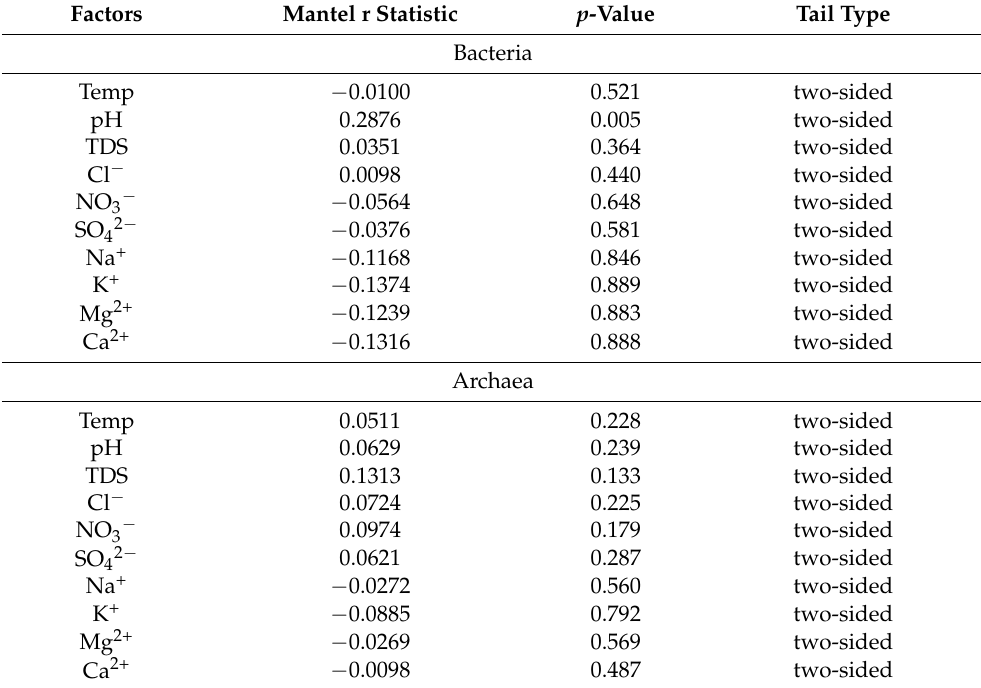
Table 2. Mantel tests using Spearman’s correlation (permutations = 999) of weighted UniFrac dissimilarities between all communities sampled and each physiochemical